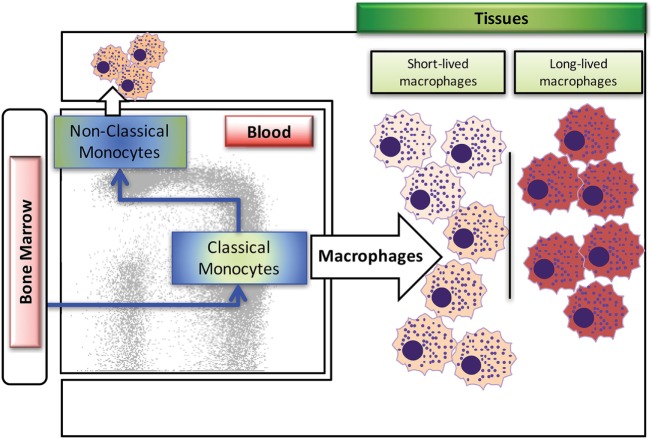
Summary of blood monocyte and dendritic cells (DC) differentiation in rhesus macaques. Myeloid precursor cells in the bone marrow migrate into blood and give rise to CD14+CD16− classical monocytes. A large proportion of these classical monocytes rapidly disappear from the circulation to become tissue macrophages. A fraction of the classical monocytes differentiate into CD14+CD16+ intermediate monocytes and then into CD14−CD16+ non-classical monocytes in the circulation. The populations of mDCs, pDCs, and perhaps other unidentified DCs appear to differentiate from various DC precursors directly in the bone marrow prior entering the blood circulation. Figure modified from Ref. (8). Copyright 2015. The American Association of Immunologists, Inc.